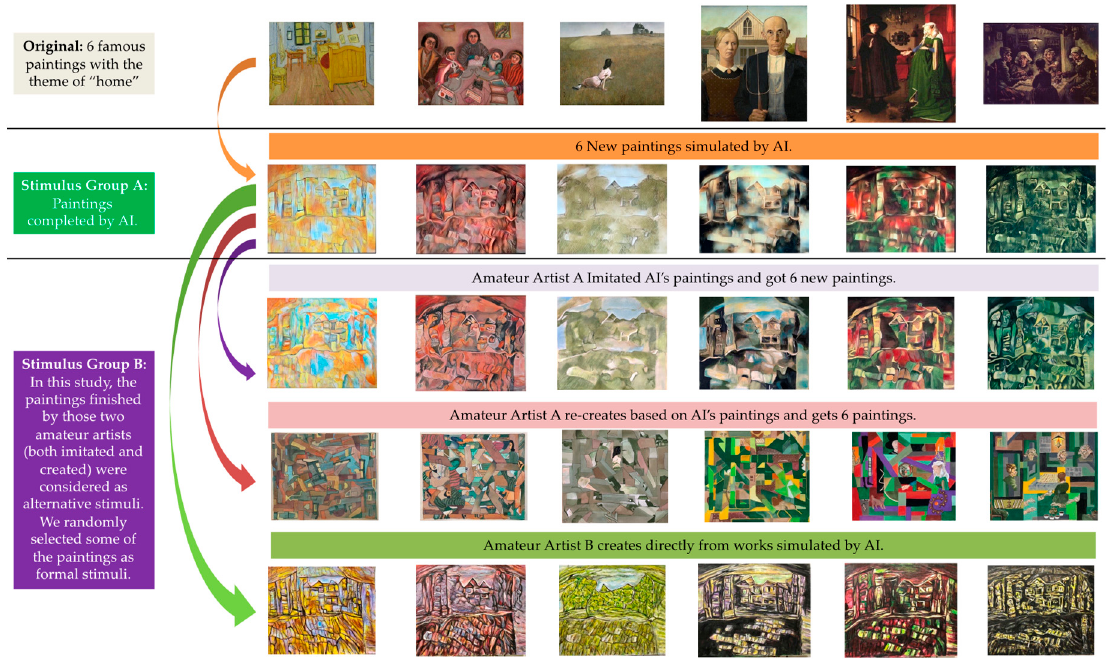
Figure 1. Original paintings and the works completed in different modes. (Source: this study).